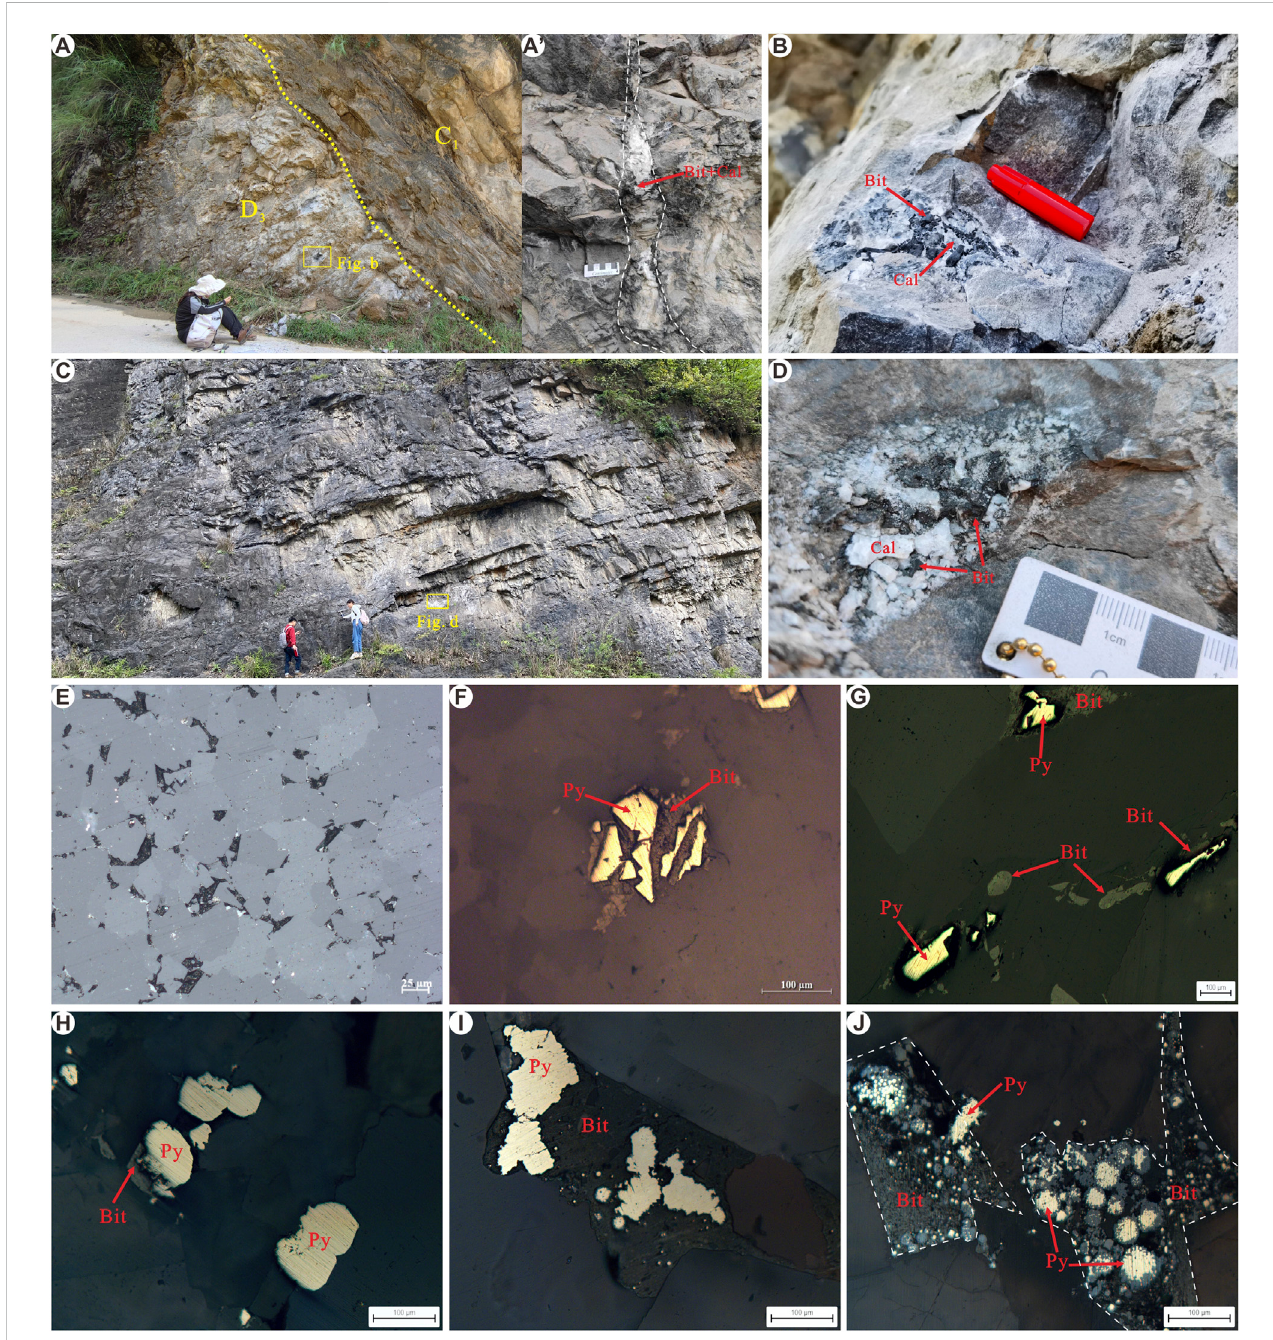
FIGURE 7 (A) The outcrop of the Xujiazhai paleo-oil reservoir. Bitumen in the Devonian; (A 9 ) Bitumen produced in the Carboniferous, found at 30 m northeast of point “ A. ” Bitumen is distributed in the calcite veins or incorporated in the calcite grains in the form of fi ne granular or water droplets; (B) The bitumen of a water droplet in the upper Devonian intergrown with calcite (Xujiazhai); (C) Xinchang pro fi le outcrop of the Xiaocaoba paleo-oil reservoir; (D) Bitumen distributed in dissolution voids of upper Devonian dolomite and intergrown with recrystallized calcite (Xiaocaoba); (E) The intercrystalline pores of dolomite mostly fi lled with bitumen (Xujiazhai); (F,G) The irregular pyrite associated with bitumen in the Xujiazhai paleo-oil reservoir; (H – J) The semi-hedral pyrite associated with bitumen in the Xiaocaoba paleo-oil reservoir (H) , irregular (I) and fi ne-grained aggregate strawberry (J) . The strawberry pyrite partially oxidized to grayish goethite. Py, pyrite; Cal, calcite; Bit,